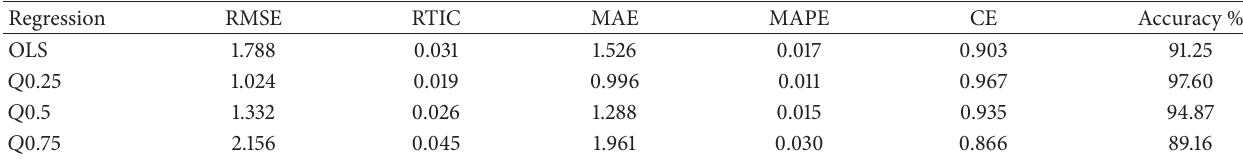
Table 4: Evaluation indicators and result of total predictive